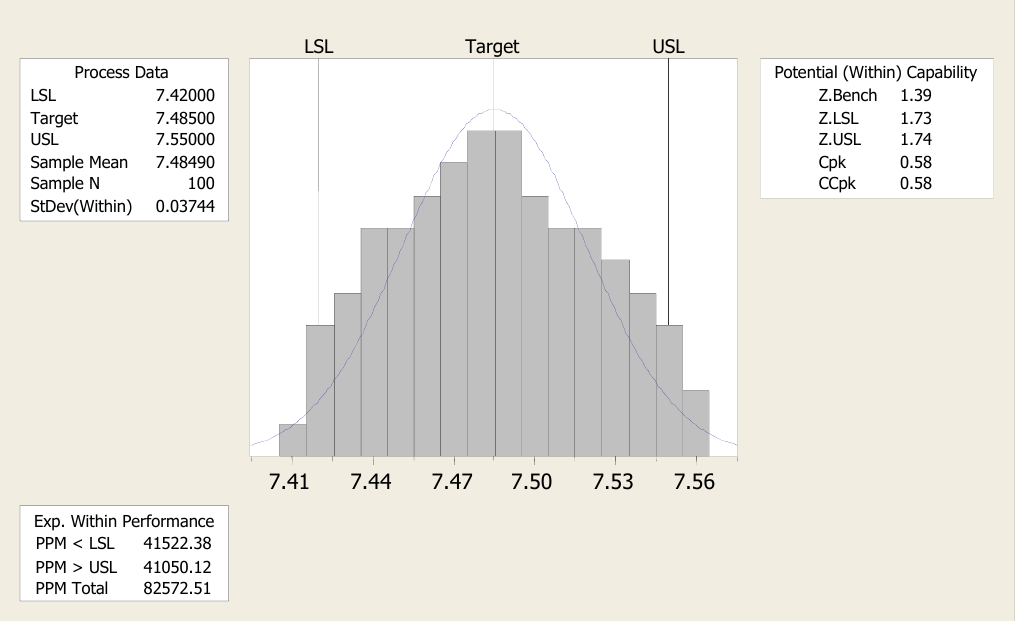
Fig. 5. Process Capability Analysis for thread undercut diameter